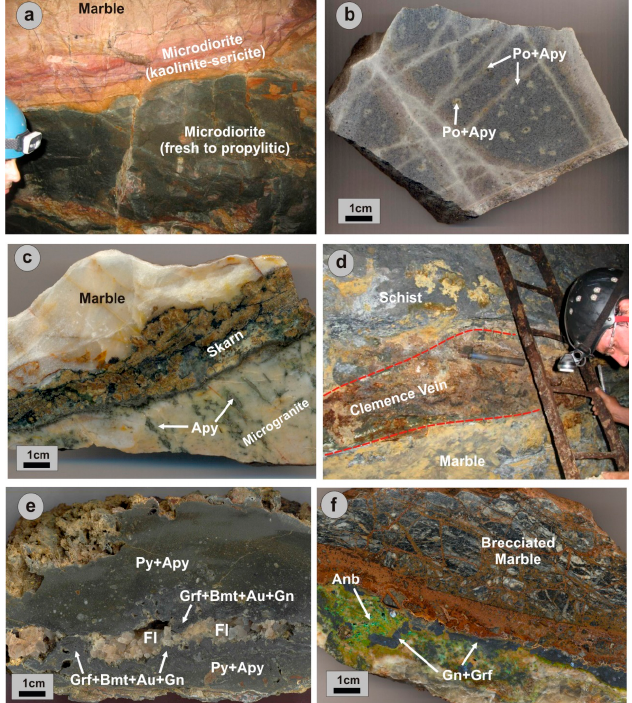
Figure 2. Field photos and hand specimens of granitoids and Ni-bearing ores in the Lavrion district. ( a ) Propylitic- and kaolinite-sericite-altered microdiorite dike from the Jean Baptiste deposit; ( b ) carbonate-sericite-quartz veinlets with pyrrhotite (Po) and arsenopyrite (Apy) crosscutting microgranite in the Serpieri mine; ( c ) skarn mineralization at the contact between microgranite porphyry dike, hosting arsenopyrite (Apy) mineralization, and the lower Kamariza marble; ( d ) vein-style Pb-Zn-As-Ni-Au-Bi mineralization between marble and schist from the Clemence mine; ( e ) hand specimen of banded vein-style mineralization from the Clemence mine, consisting of initial deposition of pyrite (Py) and arsenopyrite (Apy), followed by the deposition of the assemblage of gersdorffite (Grf), bismuthinite (Bmt), gold (Au) and galena (Gn), and finally by the deposition of fluorite (Fl); ( f ) brecciated marble cemented by galena (Gn) and gersdorffite (Grf) mineralization. The Ni-arsenate annabergite (Anb) is a supergene alteration product of gersdorffite (“km3” deposit).